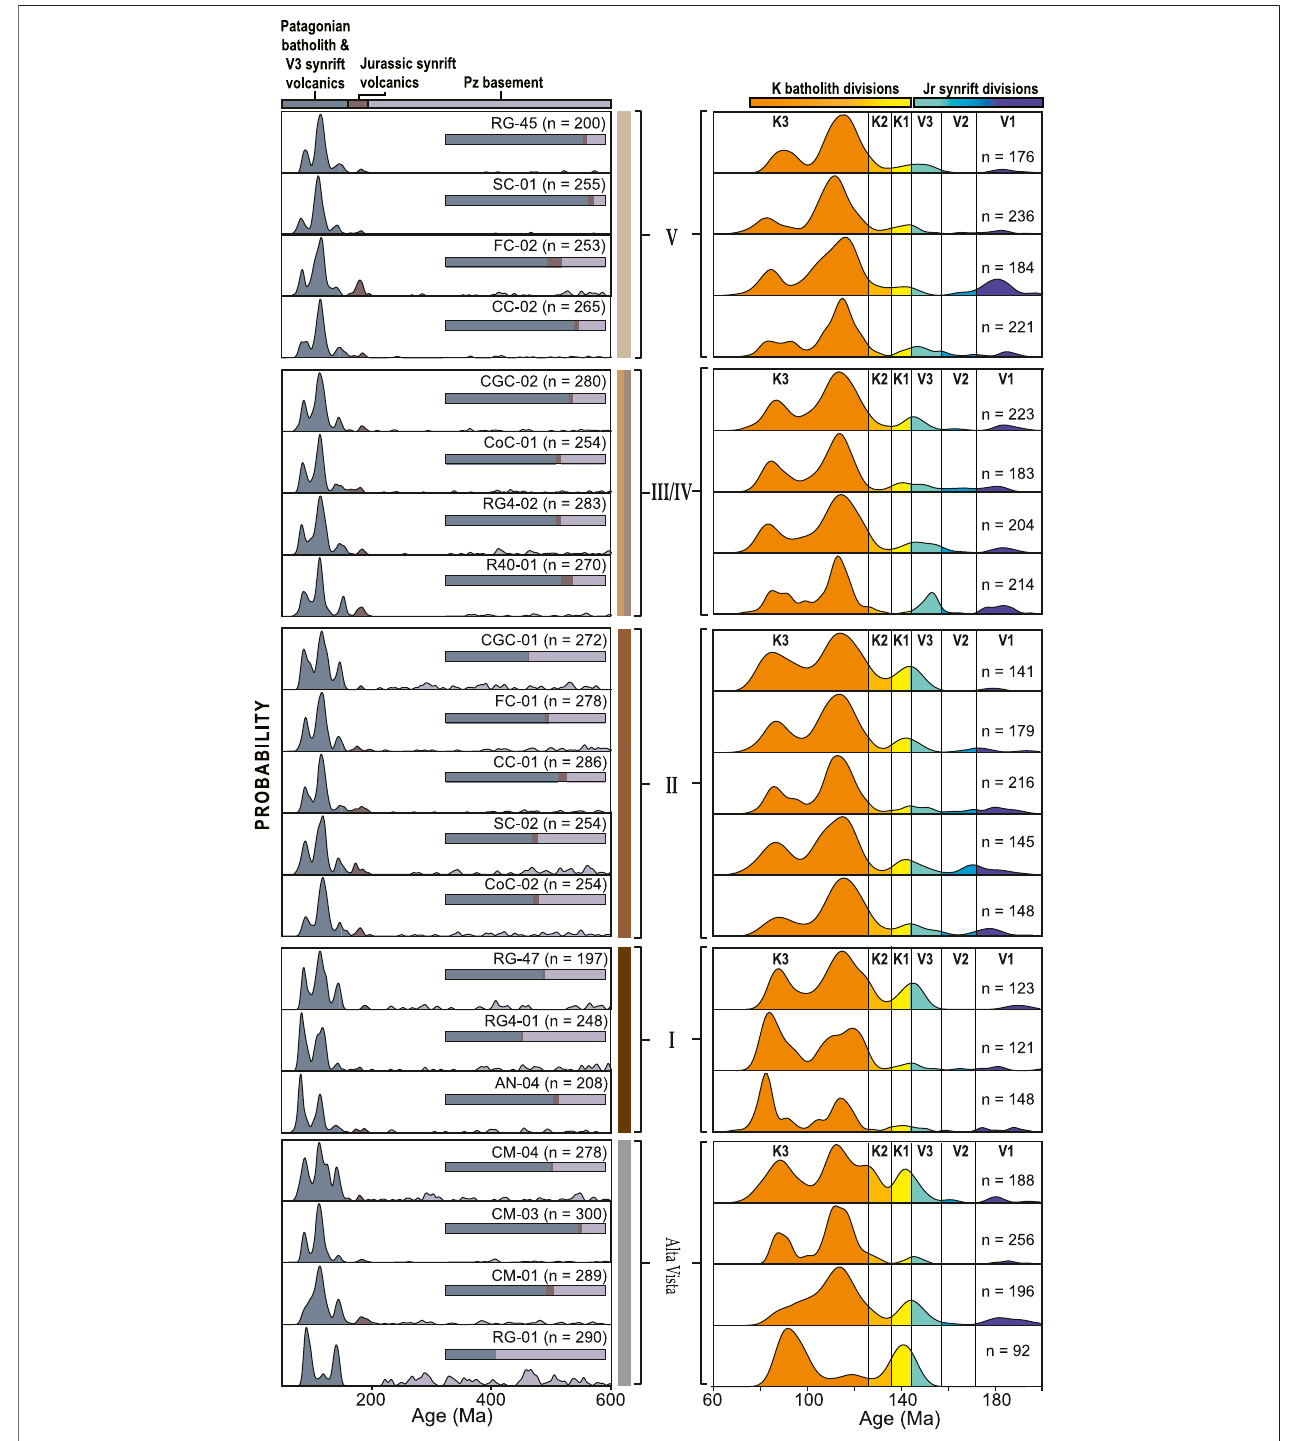
FIGURE8| Kernel densityestimates(bandwidth=5)and agedistribution bar chartsofdetrital zirconresultsfromtheAltaVistaandLaAnita Formations from60to 600 Ma(leftcolumn)and60 – 200 Ma(rightcolumn).60 – 600 MaagedataareseparatedintoPatagoniavolcanicarc,EarlyJurassicmassifunits,andPaleozoicbasement materials. 60 – 200 Ma age data are divided by periods of Cretaceous Patagonian arc magmatism (144 – 137 Ma (K1), 136 – 127 Ma (K2), and 126 – 75 Ma (K3); Hervé et al., 2007) and Jurassic silicic volcanic events (188 – 178 Ma (V1), 172 – 162 Ma (V2), and 157 – 142 Ma (V3); e.g., Pankhurst et al., 2000) La Anita Formation samples are grouped according to interpreted lithofacies association (labeled in the center colored rectangles and roman numerals).